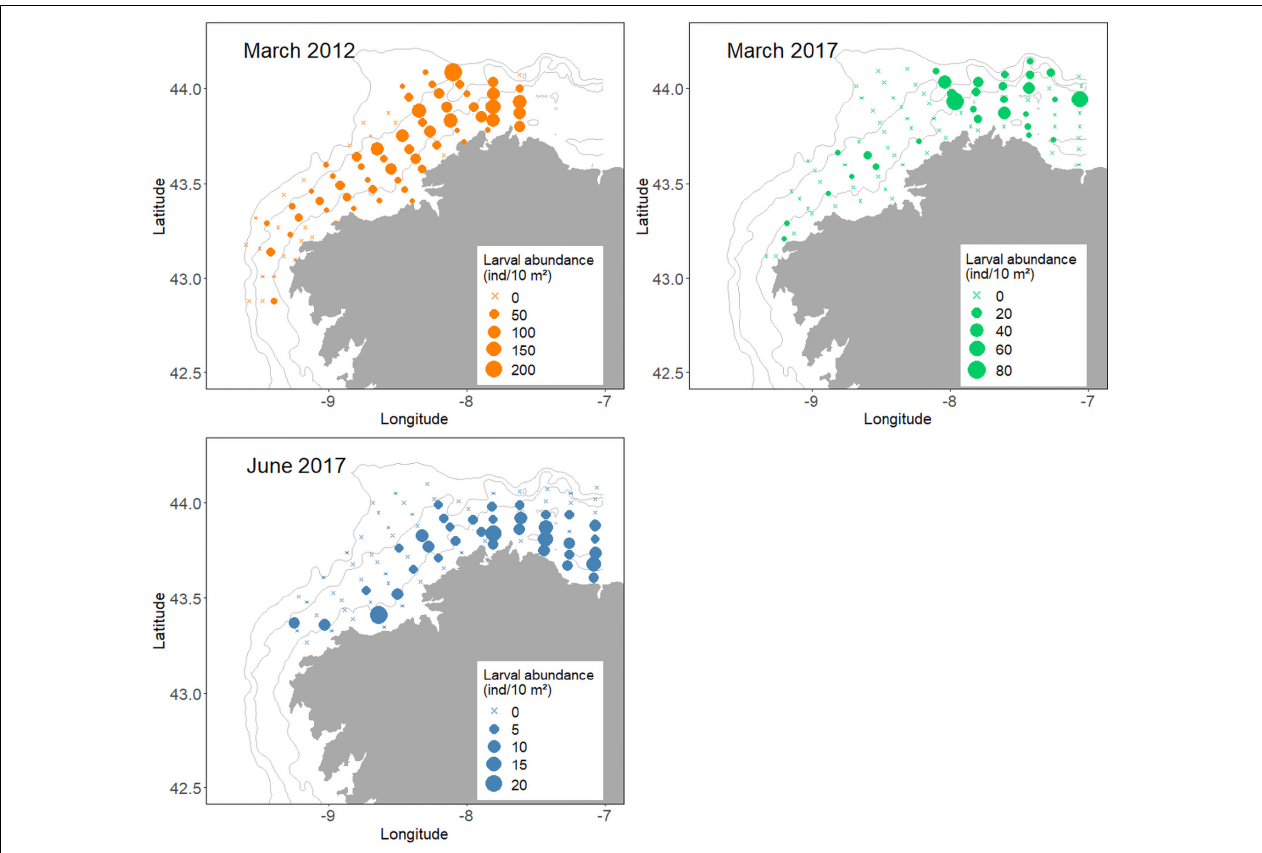
FIGURE 2 | Larval distribution and abundance (individuals/10 m 2 ) from each survey: March 2012, March 2017, and June 2017. Note the difference in the scale of the dot